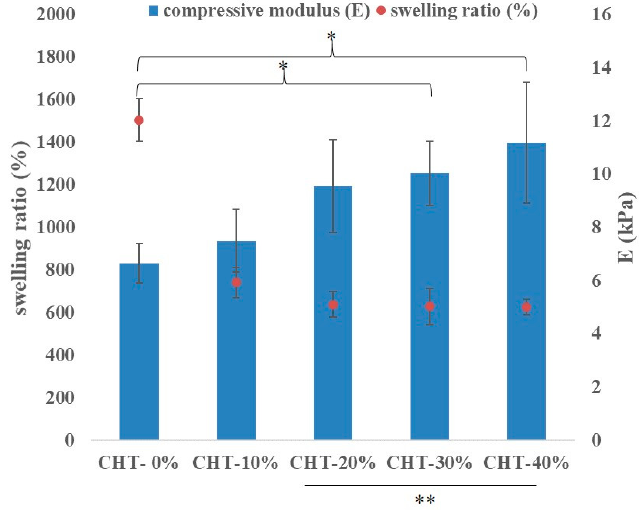
Figure 4. Swelling ratio (%) (data collected at soaking time of 120 min) (left y-axis) and compression modulus (E) (right y-axis) of CHT with different β -TCP content. Error bars represent standard deviations of triplicate measurements. * indicates a significant difference ( p < 0.05). ** represents no significant difference ( p > 0.05).